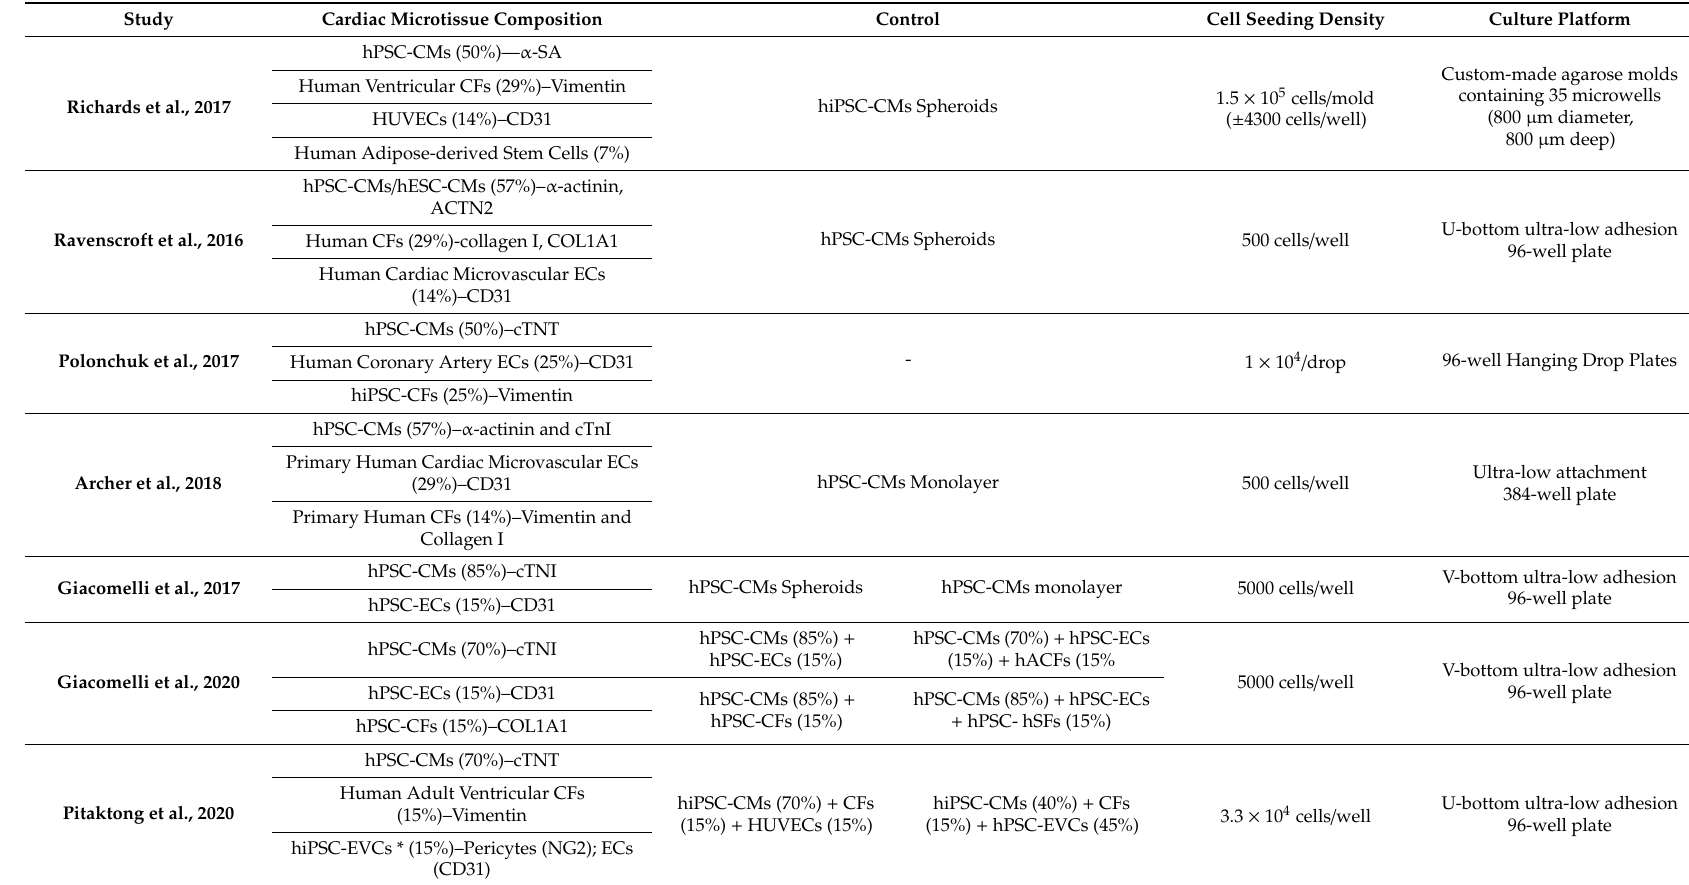
Table 3. Summary of studies reporting the generation of 3D multicellular cardiac MTs. This table highlights 3D cardiac MT composition regarding the type and proportion of the di ff erent cell types, and the culture format used for MT generation. cTnI, Cardiac Troponin I; HUVECs, Human Umbilical Vein Endothelial Cells; EVCs, Early Vascular Cells; hACFs, human Adult Cardiac Fibroblasts; hSFs, human Skin